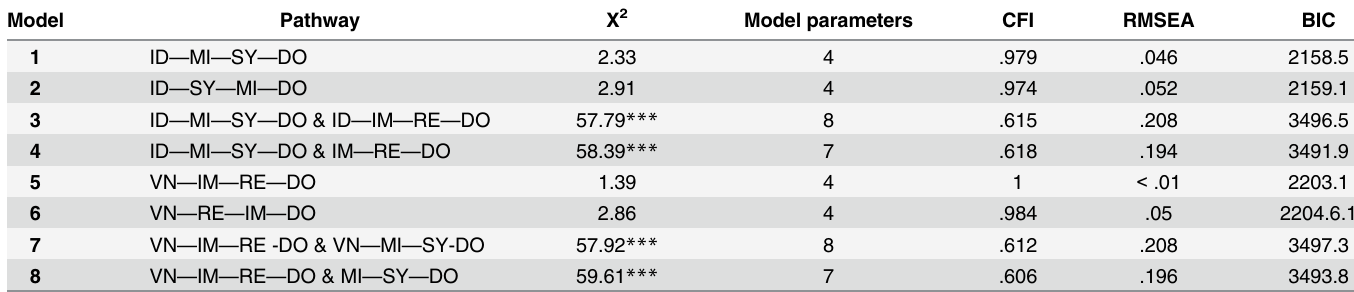
Table 4. Model Fit for Path Analyses, Study 2. Model